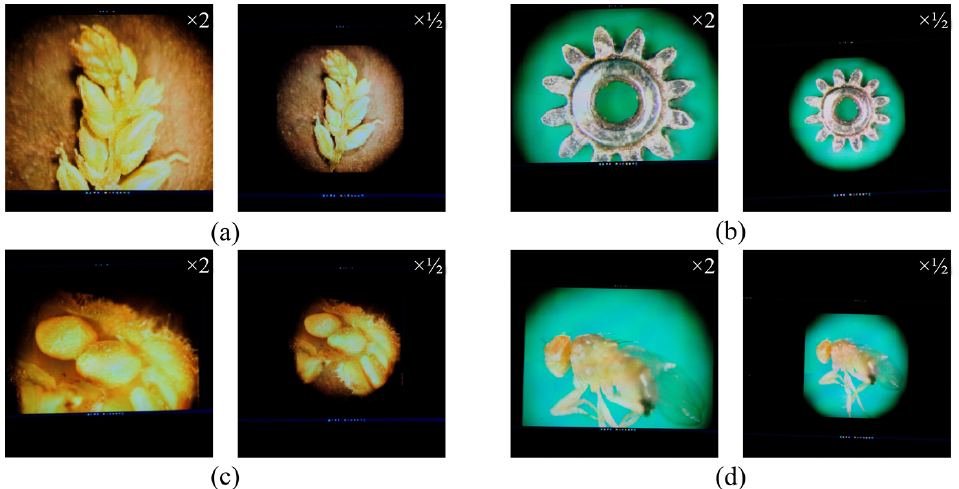
Figure 13. The zoomed-in/zoomed-out visualizations (scale factor = 2) for ( a ) a grass seed, ( b ) a micro gear, ( c ) a balsam seed, and ( d ) a fruit